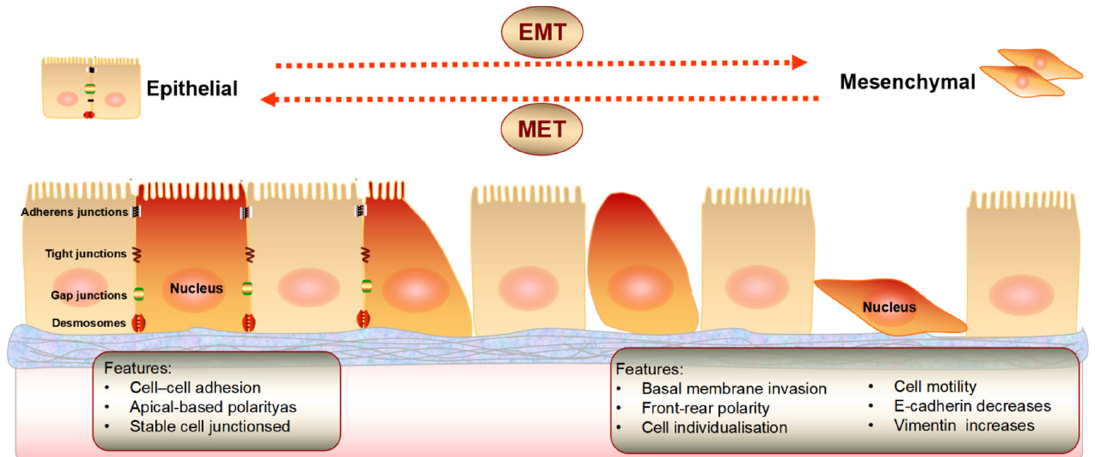
Figure 2. The conversion of epithelial mesenchymal transition (EMT) and mesenchymal epithelial transformation (MET).